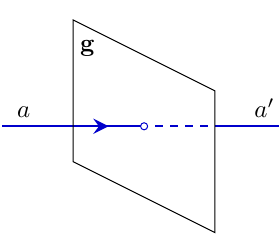
Figure 1 . When a line (surface) operator of type a crosses a codimension-one symmetry defect of type g 2 G , it leaves as a line (surface) operator of a di(cid:11)erent type a 0 . If the line (surface) operator generates a higher-form global symmetry, this represents the action of 0-form symmetry G on the higher-form symmetries by automorphisms a 0 = (cid:26) g ( a